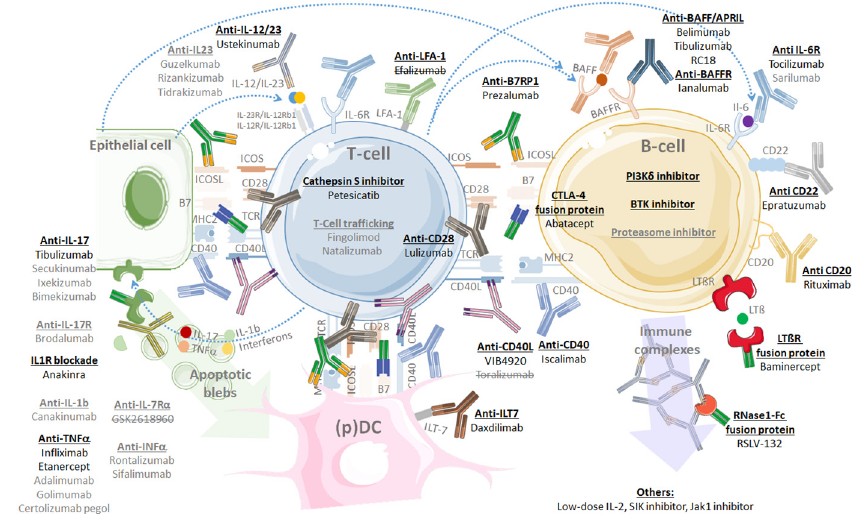
Figure 4. Synoptic view of targeted drugs (being) studied in pSS. Therapeutic classes are in bold. Biotherapies and small molecules are in black if they have been the subject of one or more trials in pSS or in grey if they exist but have not been tested in pSS. Names in strikethrough are drugs whose development has been stopped because of unacceptable side effects or because of portfolio prioritization.